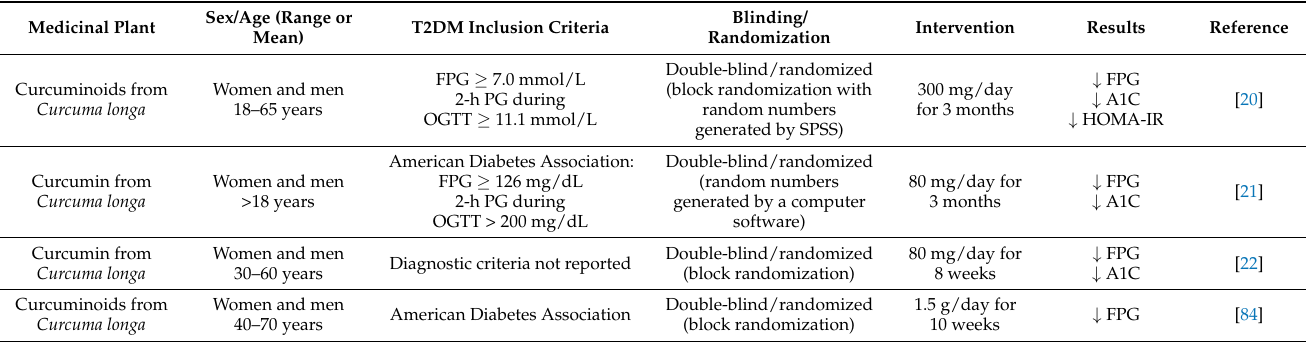
Table 3. Curcuma longa : clinical evidence in type 2 diabetes